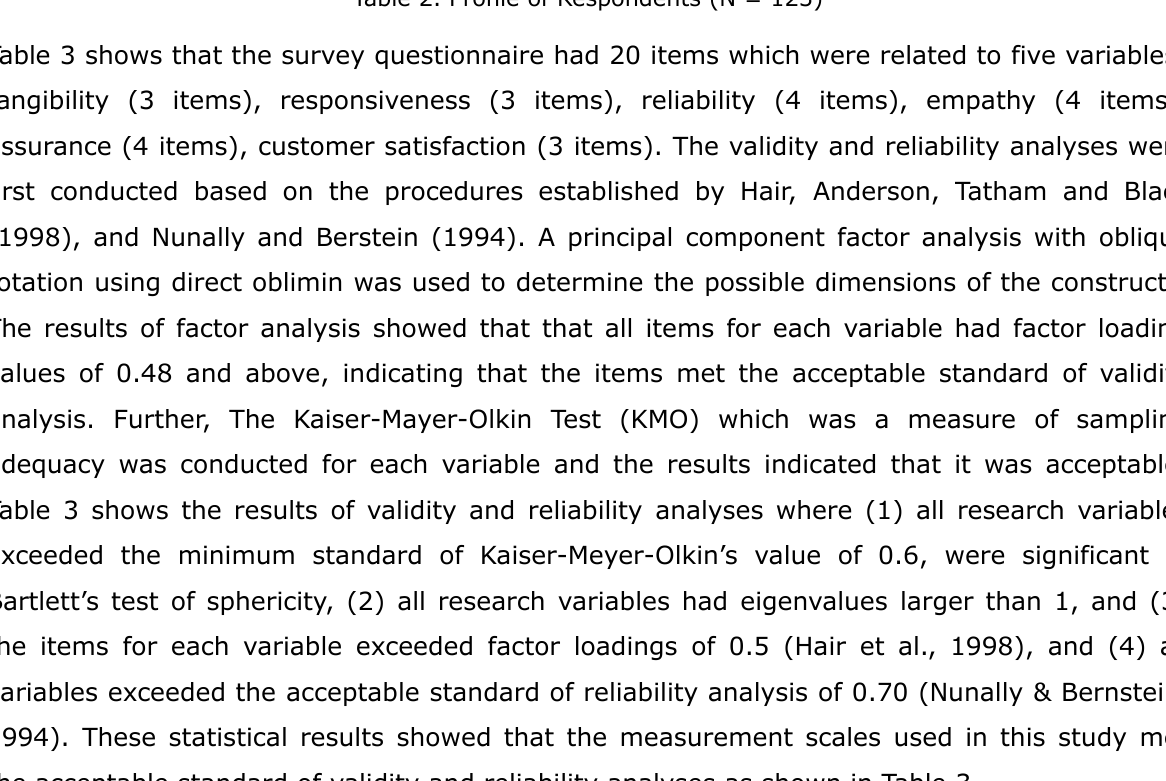
Table 2. Profile of Respondents (N =